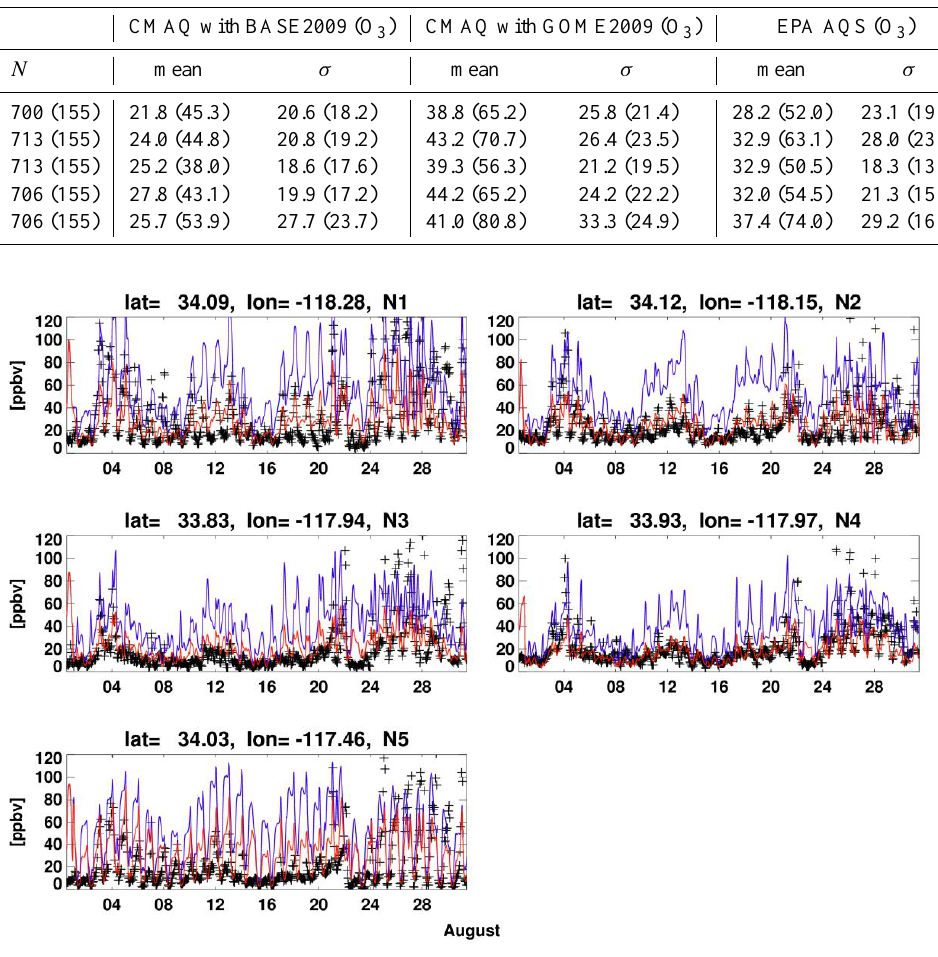
Fig. 5. Surface NO x concentrations at EPA AQS stations (black crosses), corresponding baseline CMAQ simulations with baseline emissions, BASE2009 (blue), and CMAQ simulations with GOME-2-adjusted NO x emissions, GOME2009 (red) at the five station grids (see the right panel of Fig. 3, 1: Los Angeles, 2: South Pasadena, 3: Anaheim, 4: La Habra, and 5: Riverside) in August 2009.